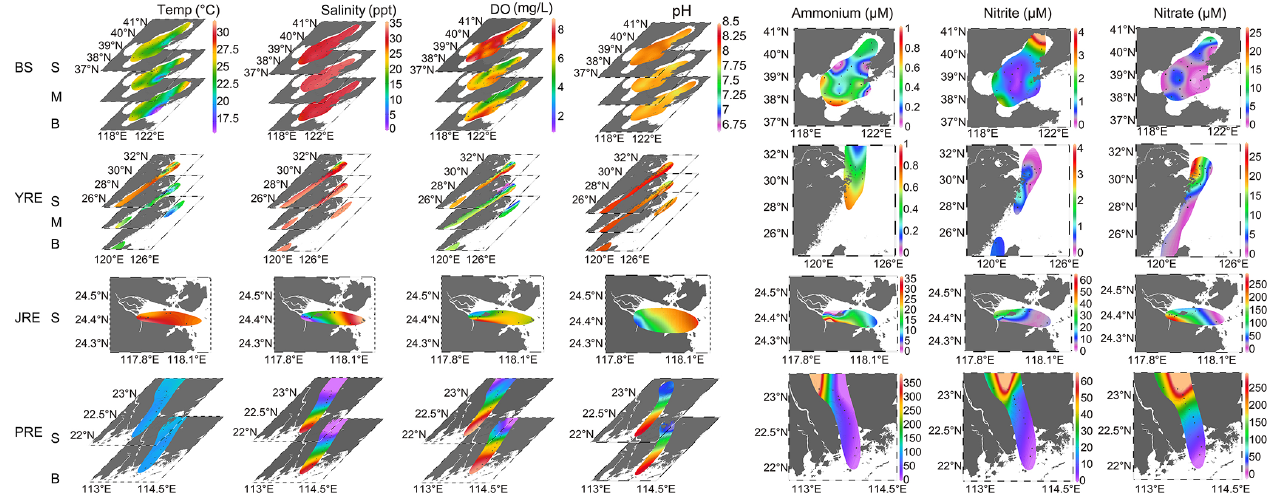
Figure 2. Temperature (Temp), salinity, dissolved oxygen (DO), pH, ammonium, nitrite, and nitrate concentration distributions in the Bohai Sea (BS), Yangtze River estuary (YRE), Jiulong River estuary (JRE), and Pearl River estuary (PRE). Data from the surface layer (S), middle layer (M), and bottom layer (B) were shown for temperature, salinity, DO, and pH. Details about the depth of samples are listed in Table S1. Depth-integrated mean values were used for ammonium, nitrite, and nitrate concentration